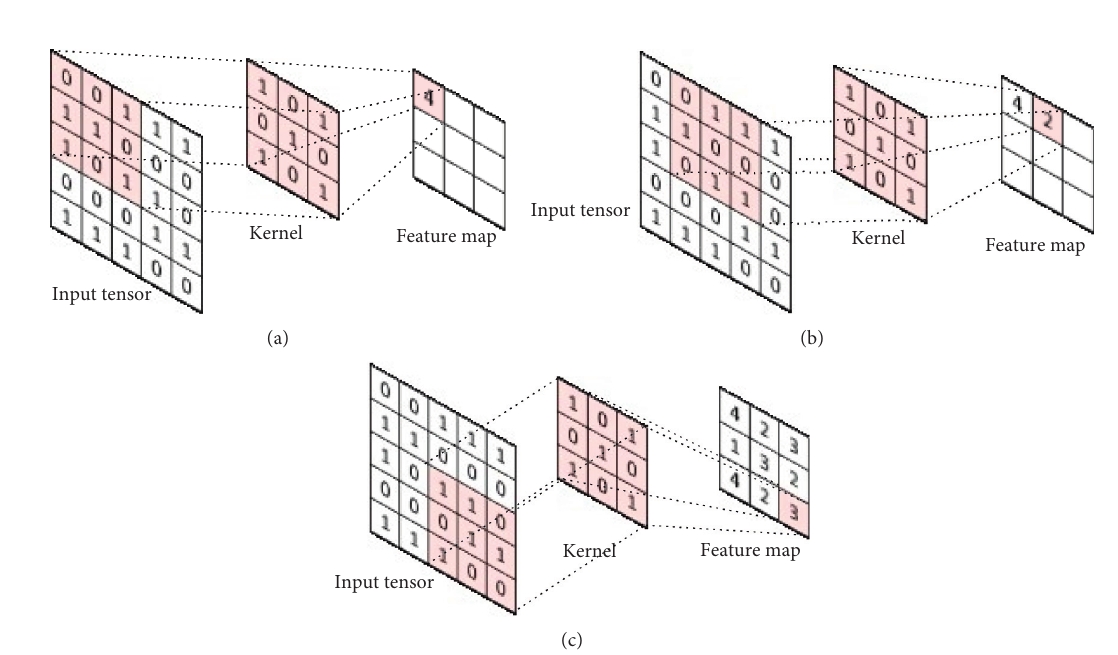
Figure 3: Convolution